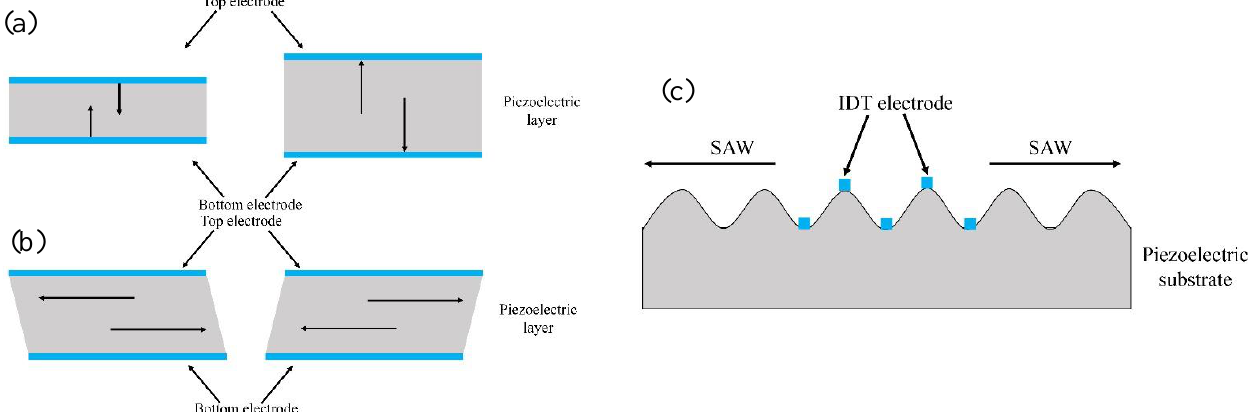
Figure 1. Profiles of ( a ) thickness-extensional mode and ( b ) thickness-shear mode of a BAW device; ( c )